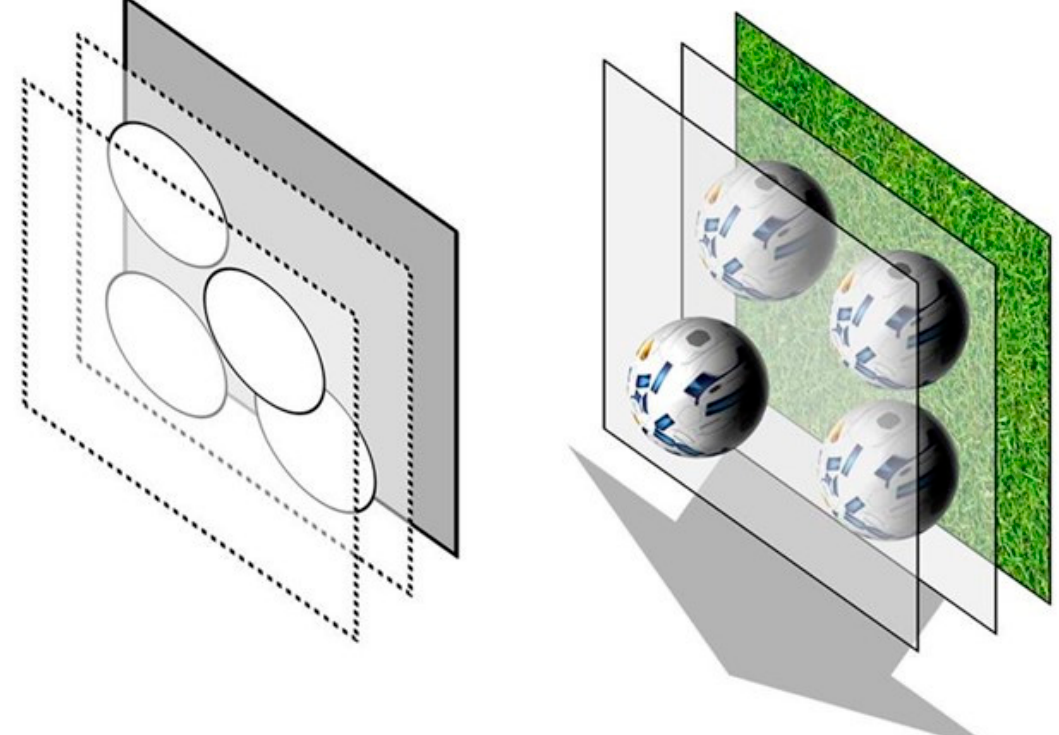
Figure 2. Illustration of the static stereo test ( left ) and dynamic stereo test ( right ). The target objects of the static test are stationary, while the target objects of the dynamic test are constantly moving towards the observer [3]. (Reproduced with permission from Georg Michelson, Extended stereopsis evaluation of professional and amateur soccer players and subjects without soccer background; published by Front. Psychol. Mov. Sci. Sport Psychol , 2014.)